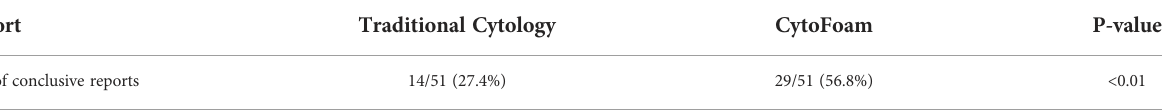
TABLE 5 Traditional cytology vs cytofoam. Rate of conclusive reports.